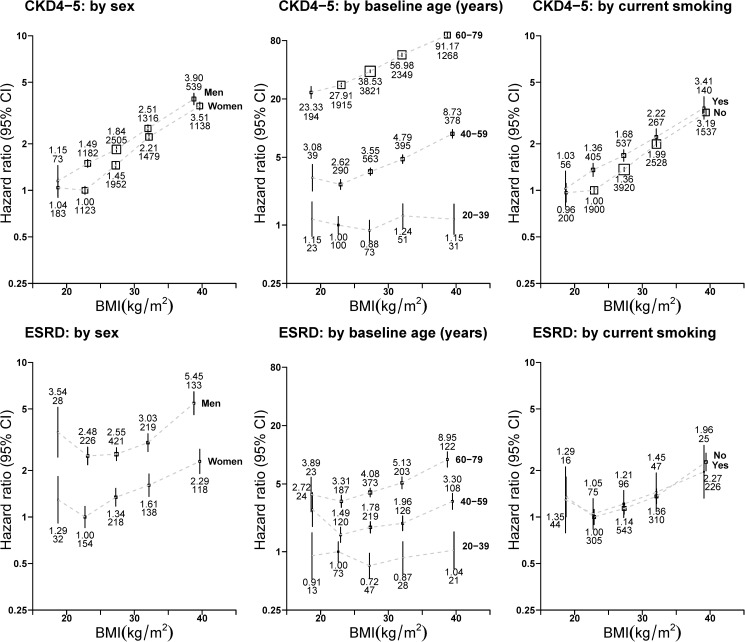
Association between baseline body-mass index and risk of advanced chronic kidney disease by sex, age and smoking status at baseline.BMI = body-mass index. CKD4-5 = CKD stage 4 or 5. ESRD = end-stage renal disease. CI = confidence interval. Analyses excluded those with outcomes at baseline or during the first 3 years of follow-up. Hazard ratios were all adjusted or stratified by age (continuous), sex, current smoking and level of deprivation (by fifths) and are plotted against the mean BMI in each BMI category. Boxes are plotted so that the area is proportional to the inverse variance of the floated hazard ratio. Error bars indicate 95% CIs and are accompanied by the hazard ratio (upper number) and number of outcomes (lower number).